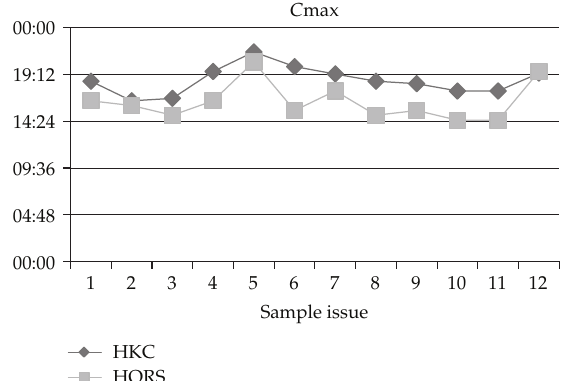
Figure 4: Comparison of “ C max” between Hasheminejad scheduling (cid:2) HKC (cid:3) and proposed scheduling (cid:2) HORS (cid:3)